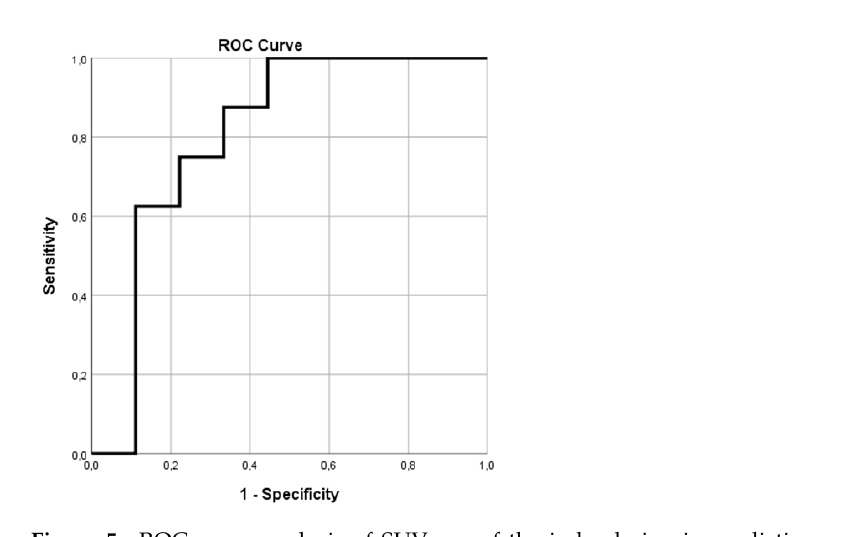
Figure 5. ROC curve analysis of SUVmax of the index lesion in predicting occurrence of SSE. AUC = 0.81 (95% CI: 0.58–1.00, p = 0.034).